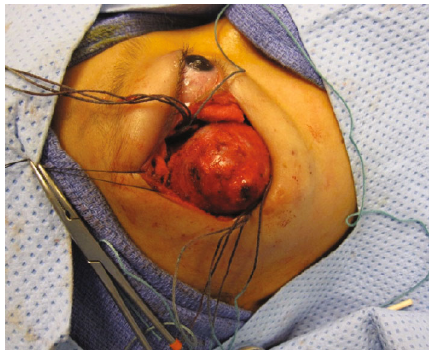
Figure 4: External photograph of the intraoperative gross appearance of the mass.